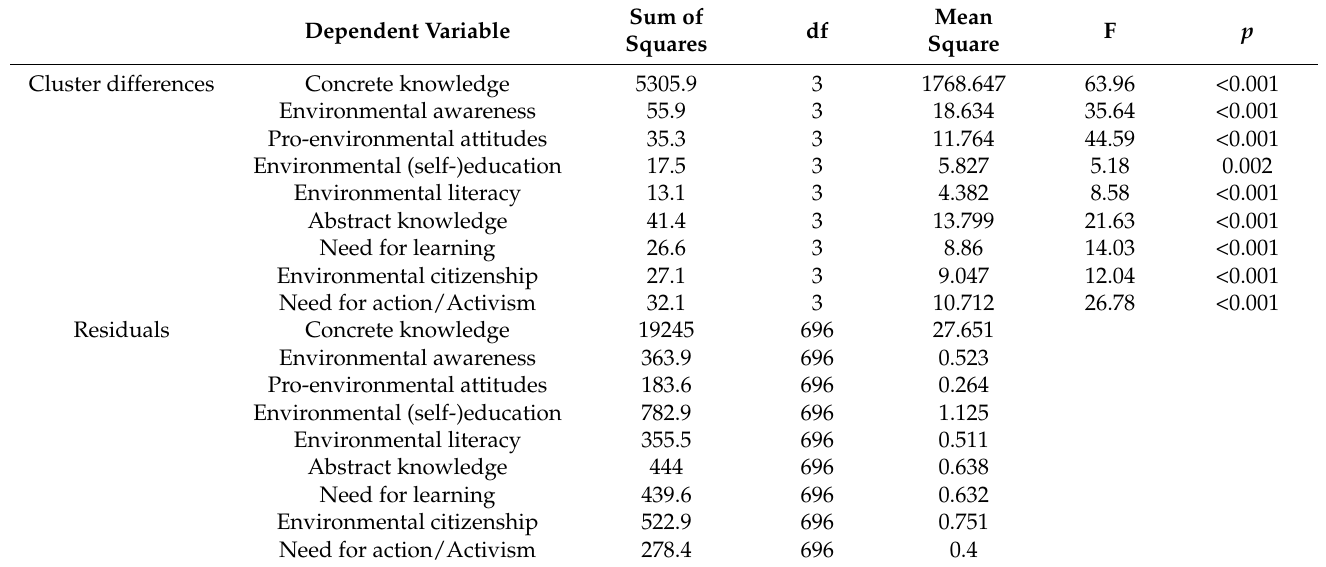
Table A2. ANOVA results for all SMEC variables compared among clusters.